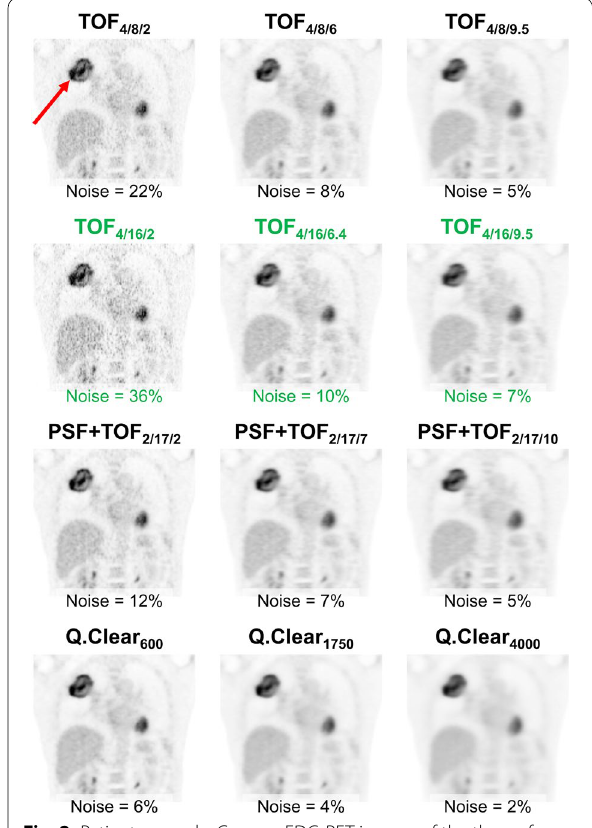
Fig. 2 Patient example. Coronar FDG-PET images of the thorax for a patient are displayed for all 12 reconstruction algorithms (body mass index 22.5 kg/m 2 ; injected activity 3.5 MBq/kg; acquisition time 180 s per bed position). The given noise level is the median of all 50 patients. Data are separated by reconstructed spatial resolution of approx. 5 mm (left column), 7 mm (middle column) or 9 mm FWHM (right column), respectively. The reference algorithm is highlighted in green. At 7 mm FWHM spatial resolution, ASP of the primary tumor (red arrow) was concordantly high (> 19.5%) with all algorithms except for